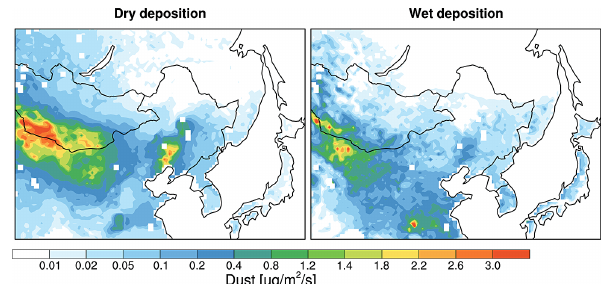
Figure 10. Spatial distribution of dry and wet deposition fluxes of dust on snow from the WRF-Chem simulations over North China in January–February 2010.